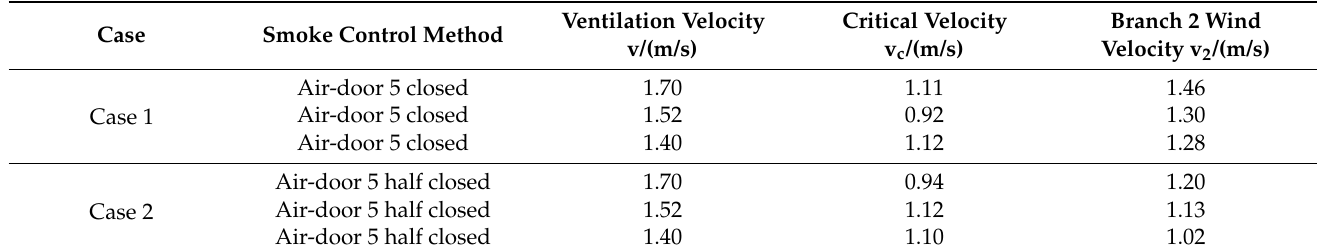
Table 3. Wind velocity in the ventilation network with parallel branches after the smoke control.